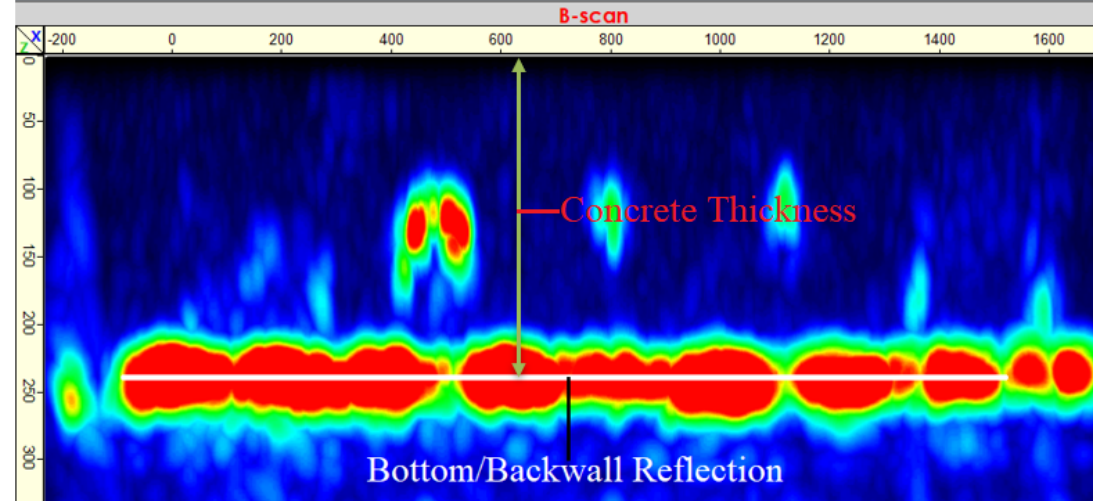
Figure 4. Measuring concrete thickness from the B-scan image.